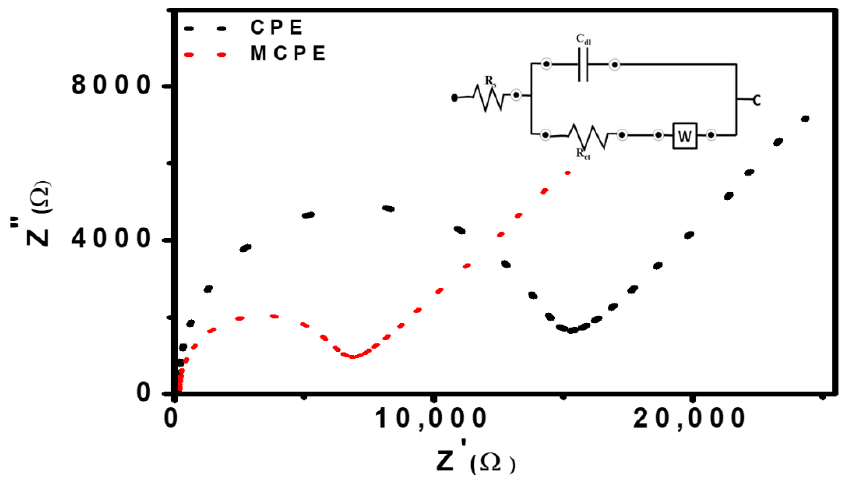
Figure 7. Nyquist plots represent the EIS measurement performed in the frequency range of 100 kHz– 0.1 Hz, in a redox solution of 5 mM [Fe(CN) 6 ] 3−/4− containing 1 M KNO 3 using CPE and MCPE for surface characterization. The inset figure is the equivalent circuit showing resistors and capacitor (c).